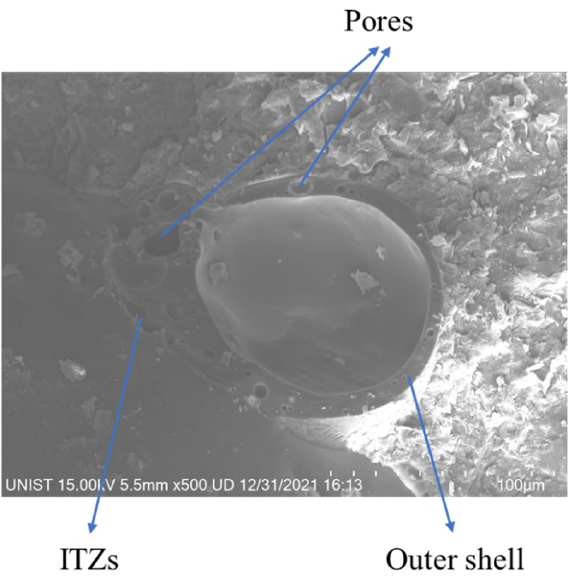
Figure 4. An SEM (Hitachi High-Technologies Co., Tokyo, Japan) image of cenosphere in the ce- ment matrix.